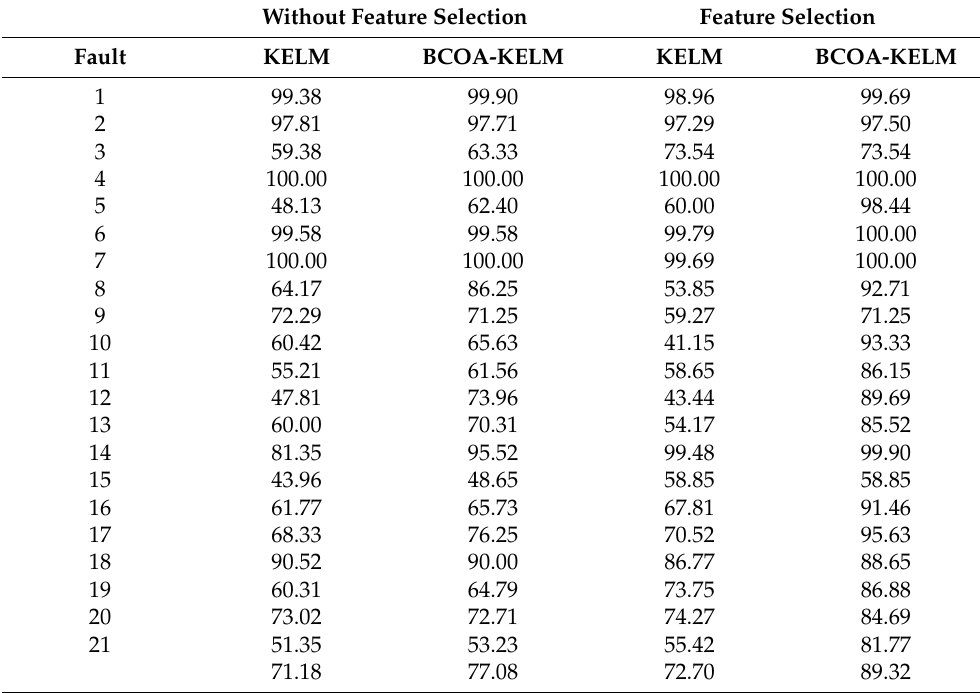
Table 8. FDR (%) of the base algorithm and related improved